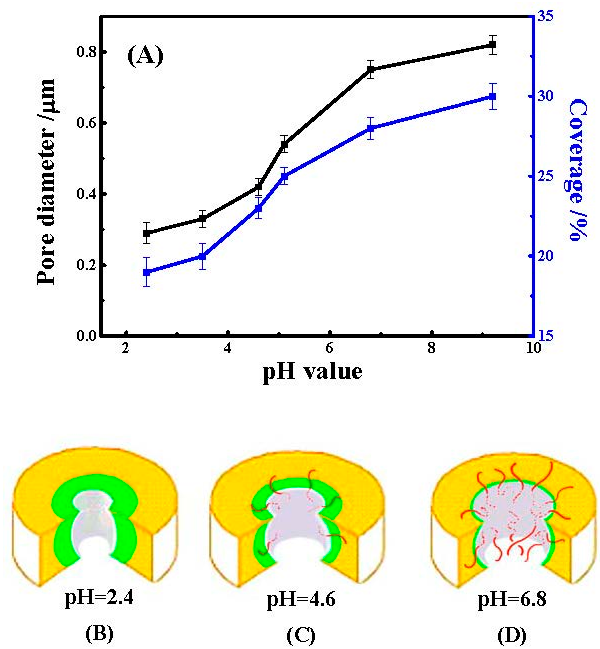
Figure 2. ( A ) The variation trend of pore size (black line) and surface coverage (blue line) according to Figure 1D, and the y-axis on the left refers to the pore diameter (µm), while the y-axis on the right indicates the percentage of pore coverage (%); ( B – D ) are schematic drawings of the PS– b –PAA microstructures in pH < 4.0, 4.0 < pH < 6.0, and pH > 6.0, respectively. The phases were assigned to the PS matrix (orange domain), the PAA domain (green domain), and the stretched PAA chains (red dotted lines).